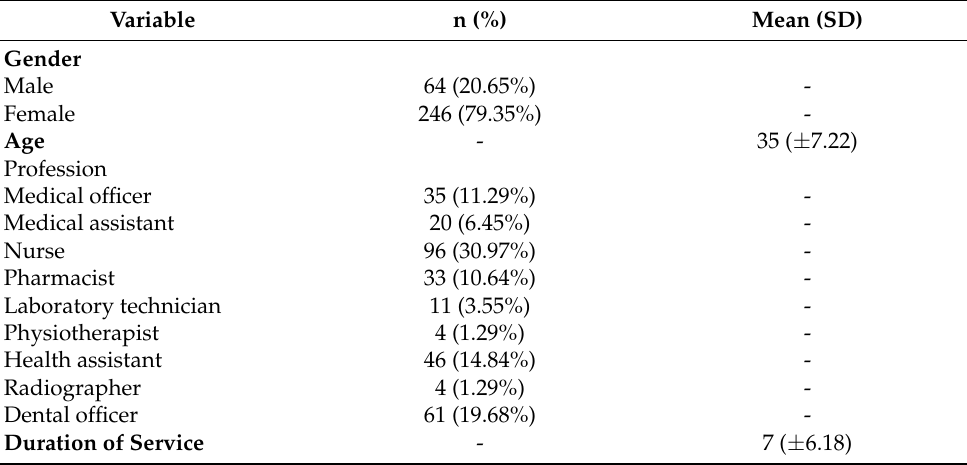
Table 1. Respondent profiles of healthcare workers who participated in the study (N =